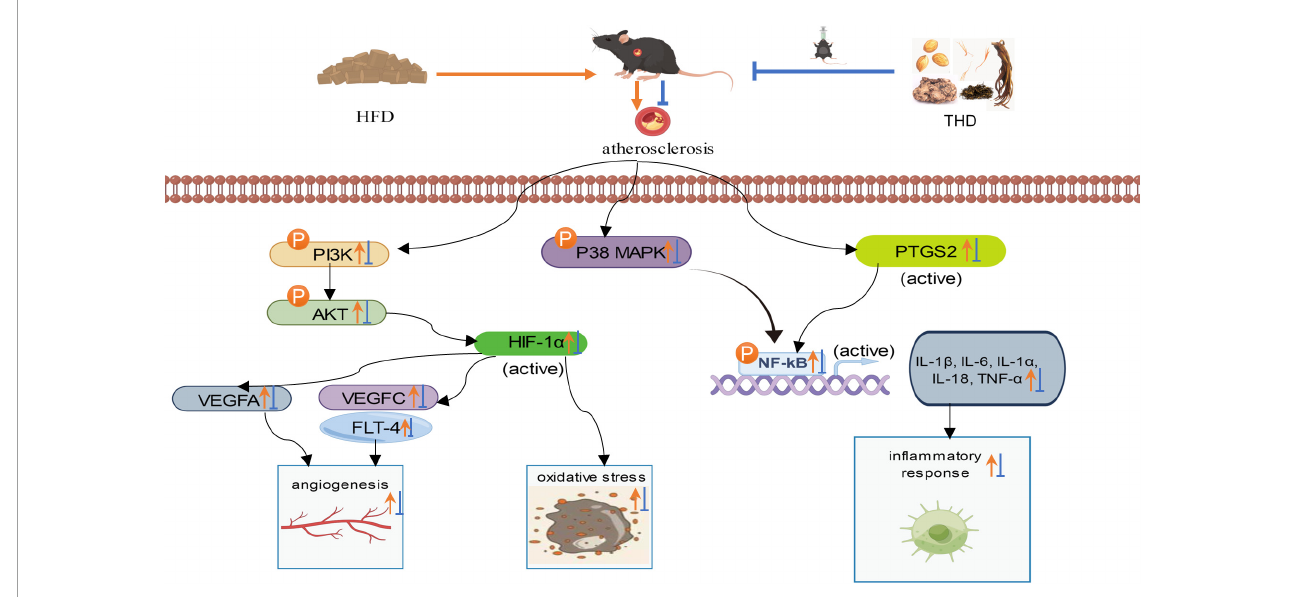
FIGURE12 Protective mechanism of THD against HFD-induced AS mice.